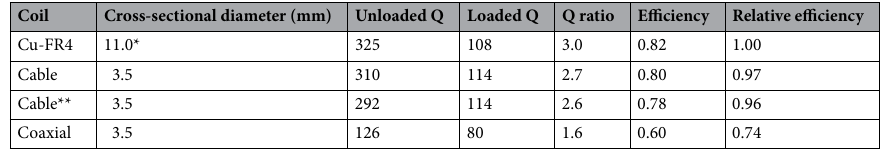
Table 1. Quality factor (Q), efficiency, and relative efficiency values measured at 23.55 MHz for 10-cm diameter loops built from various conductors. *Width. **Inner conductor and insulation removed. The loaded Q values were measured while the loops were wrapped onto a 13.5-cm diameter cylindrical dielectric 1 − Q ratio − 1 , while relative efficiency is defined as phantom. Efficiency is defined as (cid:31) normalized to that of the Cu-FR4 loop.